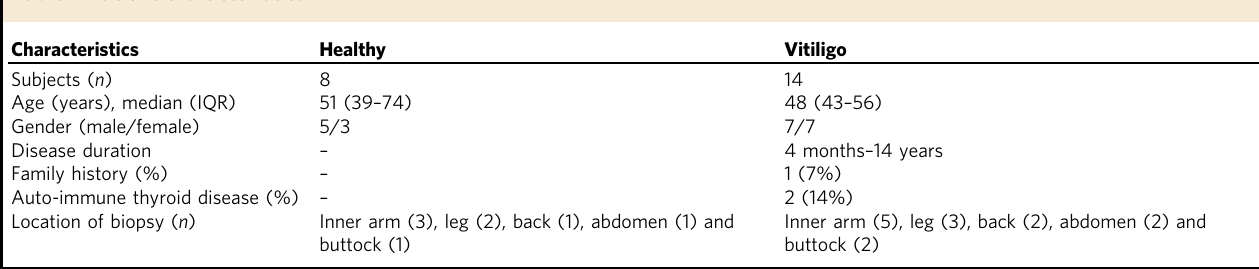
Table 1 Patient characteristics